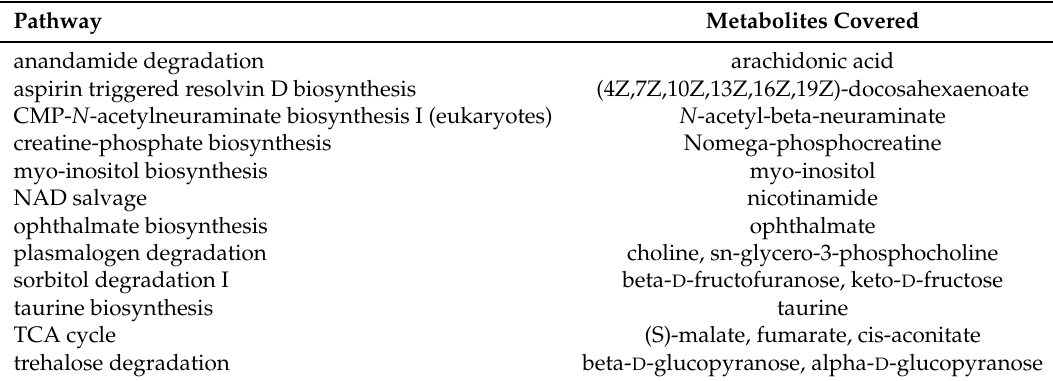
Table A7. ST000741, Pathway Covering Using Biosynthesis-Preferred Cost Function.